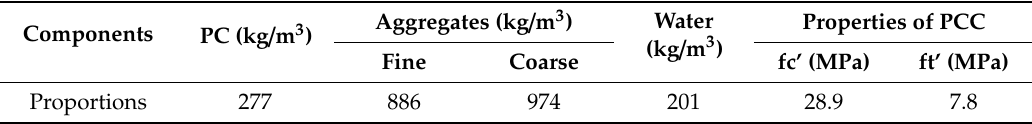
Table 1. Concrete proportion and properties to be repaired.